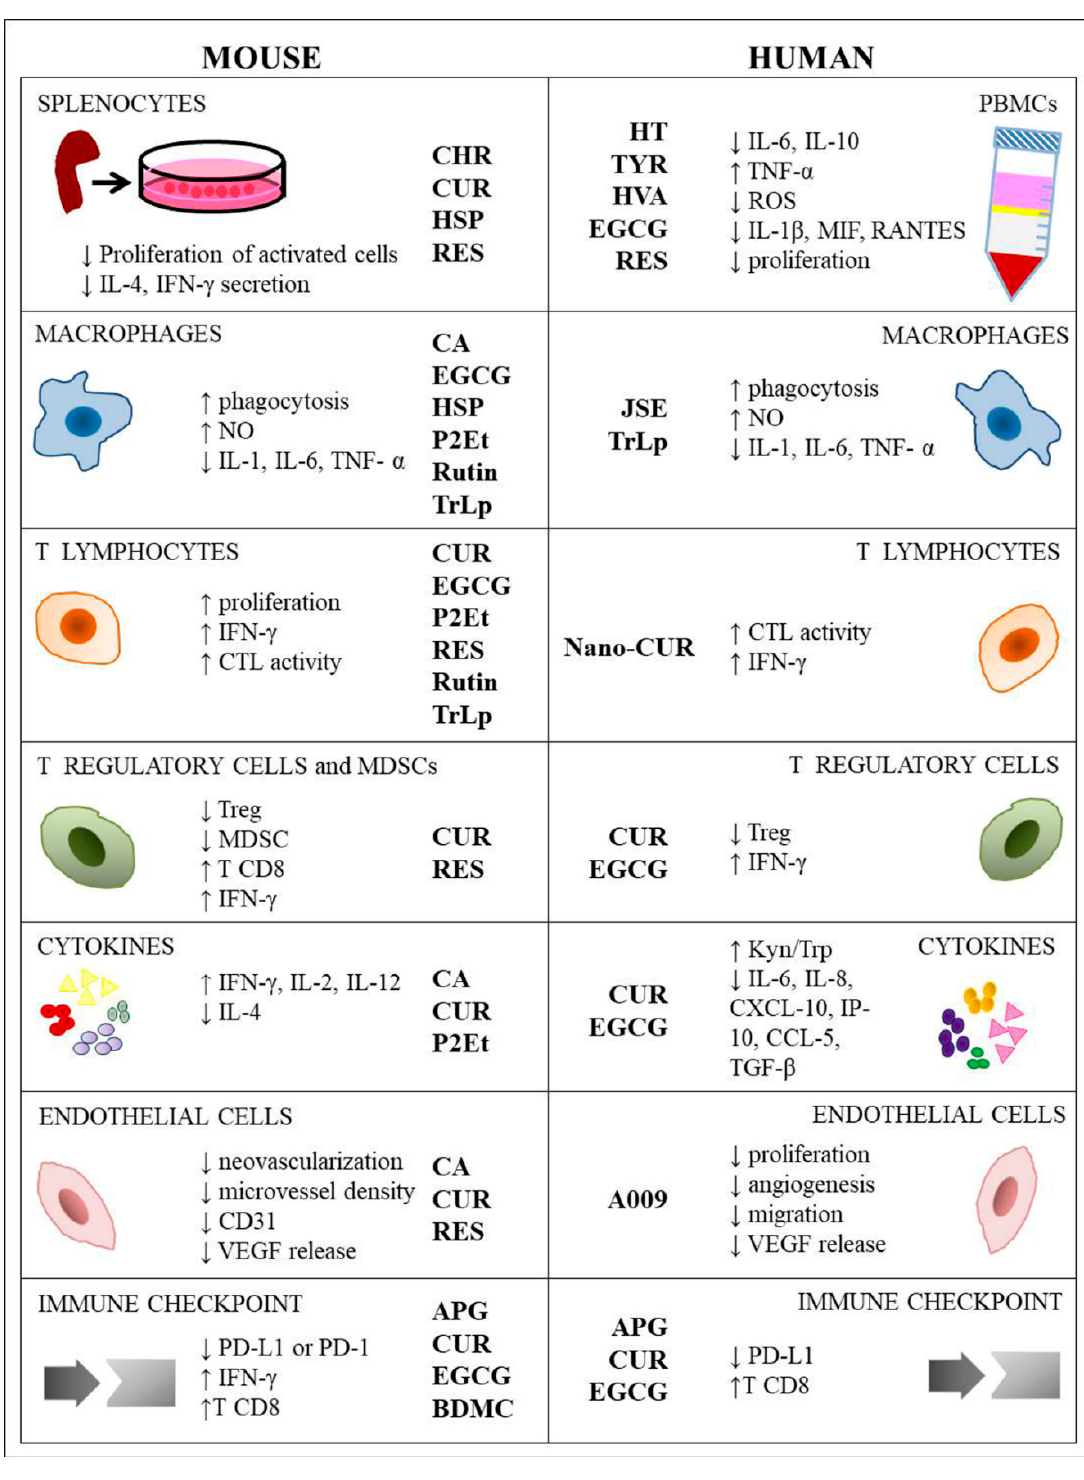
Figure 2. Effects of polyphenols on immune cells. The more common activities of polyphenols on immune cells and cytokines are reported.